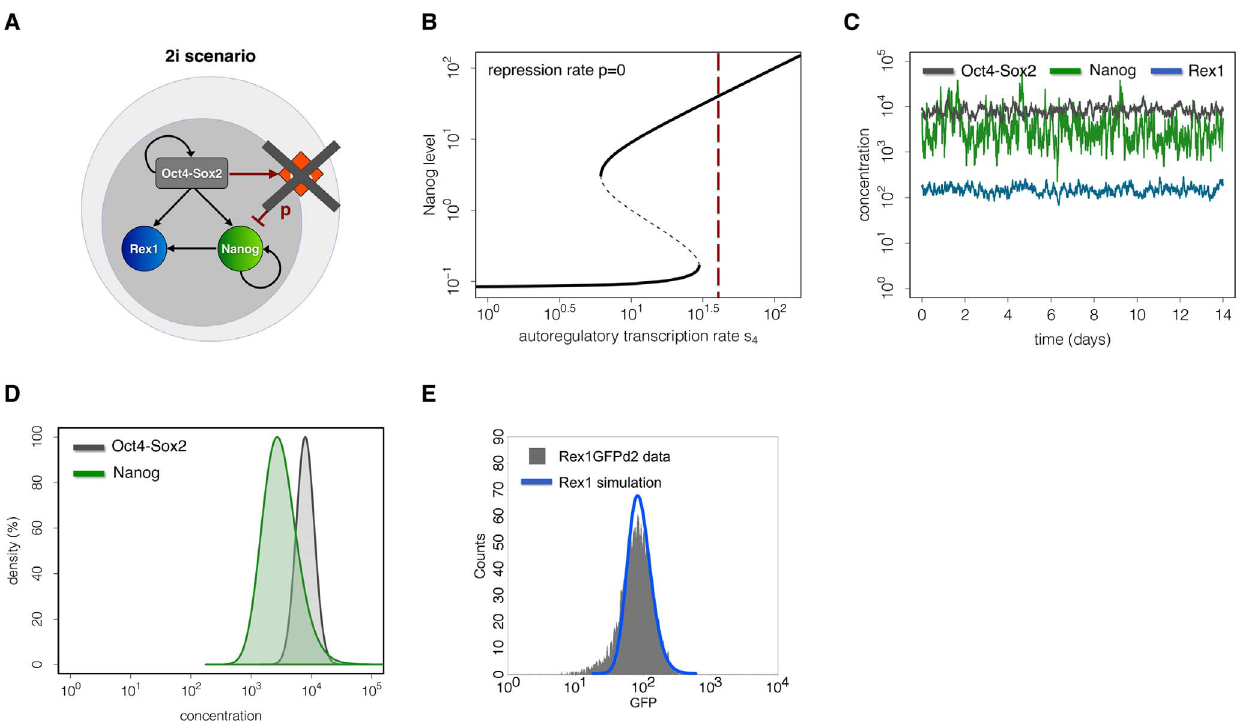
Figure 4. Mechanistic explanation and simulation results for the 2i scenario. (A) Model scheme. In the 2i scenario Erk signalling is efficiently blocked (i.e. p=0). (B) Bifurcation diagram. Keeping all regulatory rates and the transcriptional noise constant, the removal of the Erk repression in 2i shifts the Nanog level into a monostable region. (C) Single cell trajectories. The diagram shows simulated trajectories of Oct4-Sox2 (grey), Nanog (green) and Rex1 (blue) concentrations for the 2i scenario. (D) Simulated TF distributions of Nanog (green) and Oct4-Sox2 (grey) within mESC populations at time point t=4320 (i.e. 3 days of in silico culture). The homogenous high expression levels under 2i result in unimodal TF distributions. (E) Comparison of the simulation result for Rex1 (blue line) with experimental data (grey histogram) obtained from flow cytometry analysis of